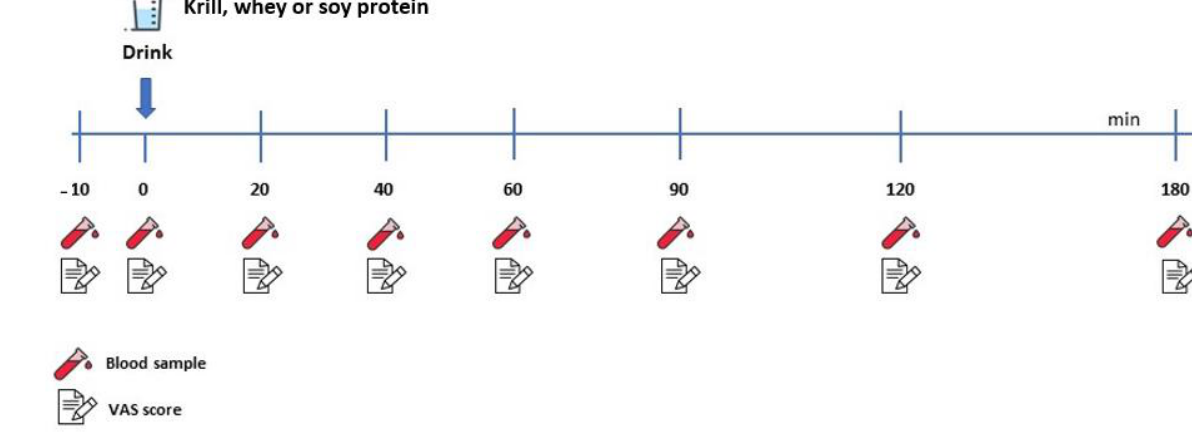
Figure 1. Experimental protocol.